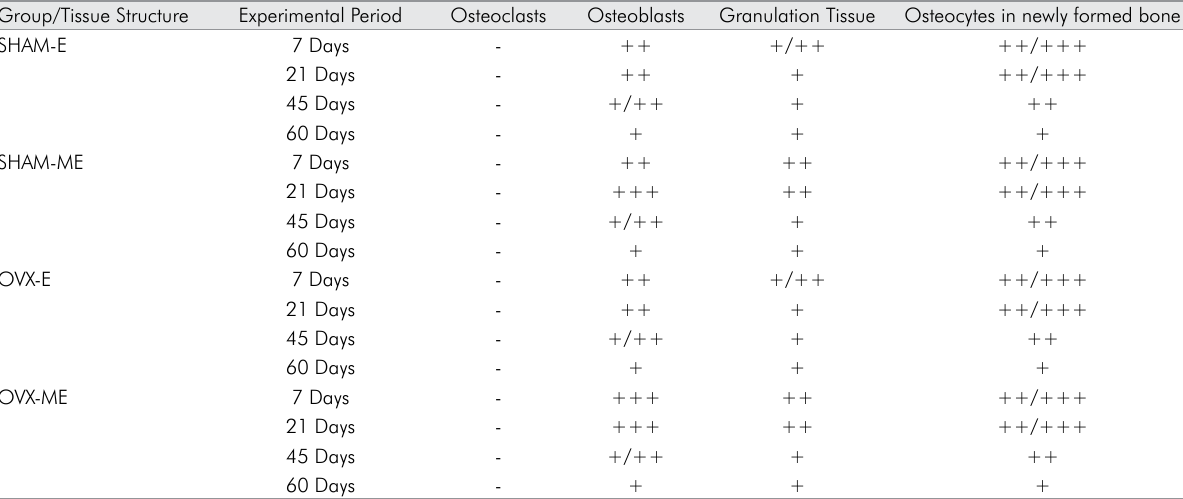
Table 3. Summary of OPG results